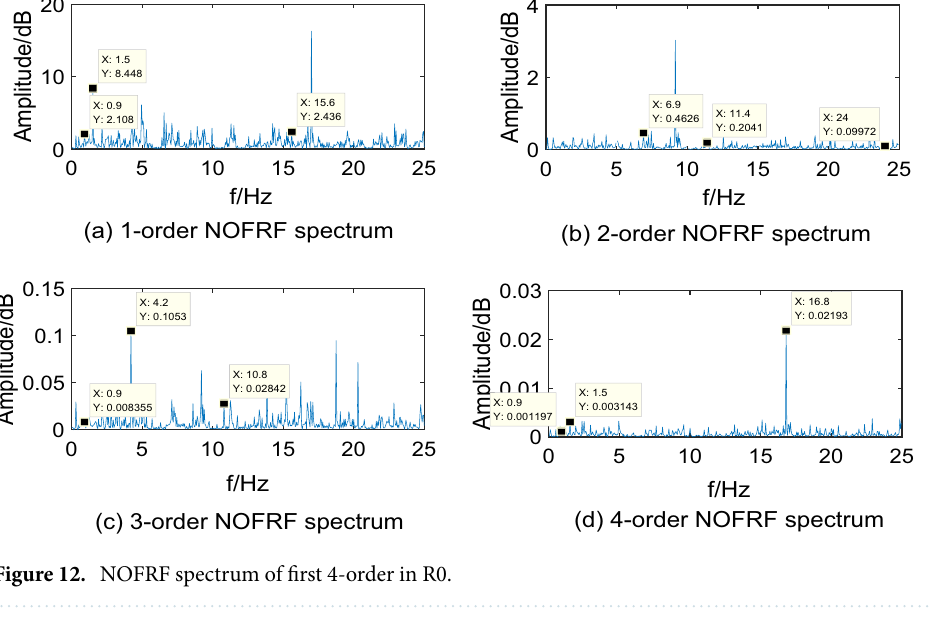
Figure 12. NOFRF spectrum of first 4-order in R0.